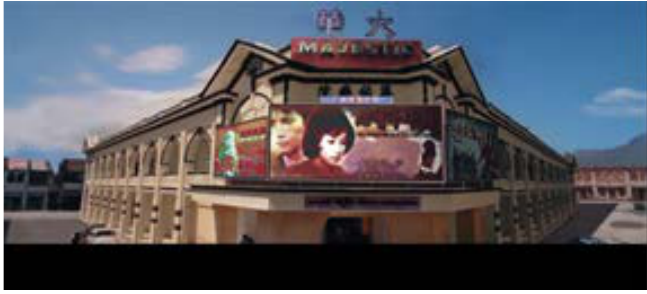
Fig. 1: The Taiwanese film Xin you qianqian jie (1973) on show at the Majestic Theatre.